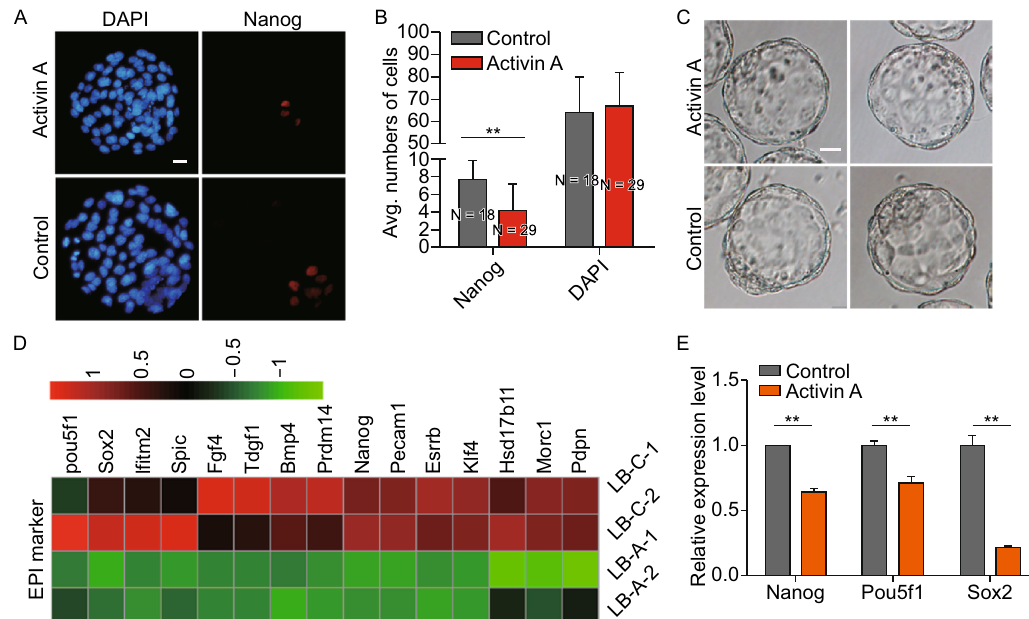
Figure 3. Activin A represses EPI lineage. (A) Nanog immunostaining in Activin A-treated and untreated embryos at E4.5. Nuclei were stained with DAPI (Blue). Scale bars, 20 μ m. (B) Average numbers of EPI cells (Nanog-positive cells) in Activin A-treated and untreated embryos at E4.5. Error bars indicate SD. ** P < 0.01 by ANOVA. N is the number of embryos examined. (C) Late blastocysts in the Activin A-treated group and the control group. Scale bars, 20 μ m. (D) Heatmap of selected genes associated with EPI lineage. Heatmap was plotted with Z-score normalized RPKM. (E) Quantitative RT-PCR analyzed the expression of genes selected by heatmap of EPI Markers. Error bars indicate SD ( n = 3). ** P < 0.01 by Student ’ s t